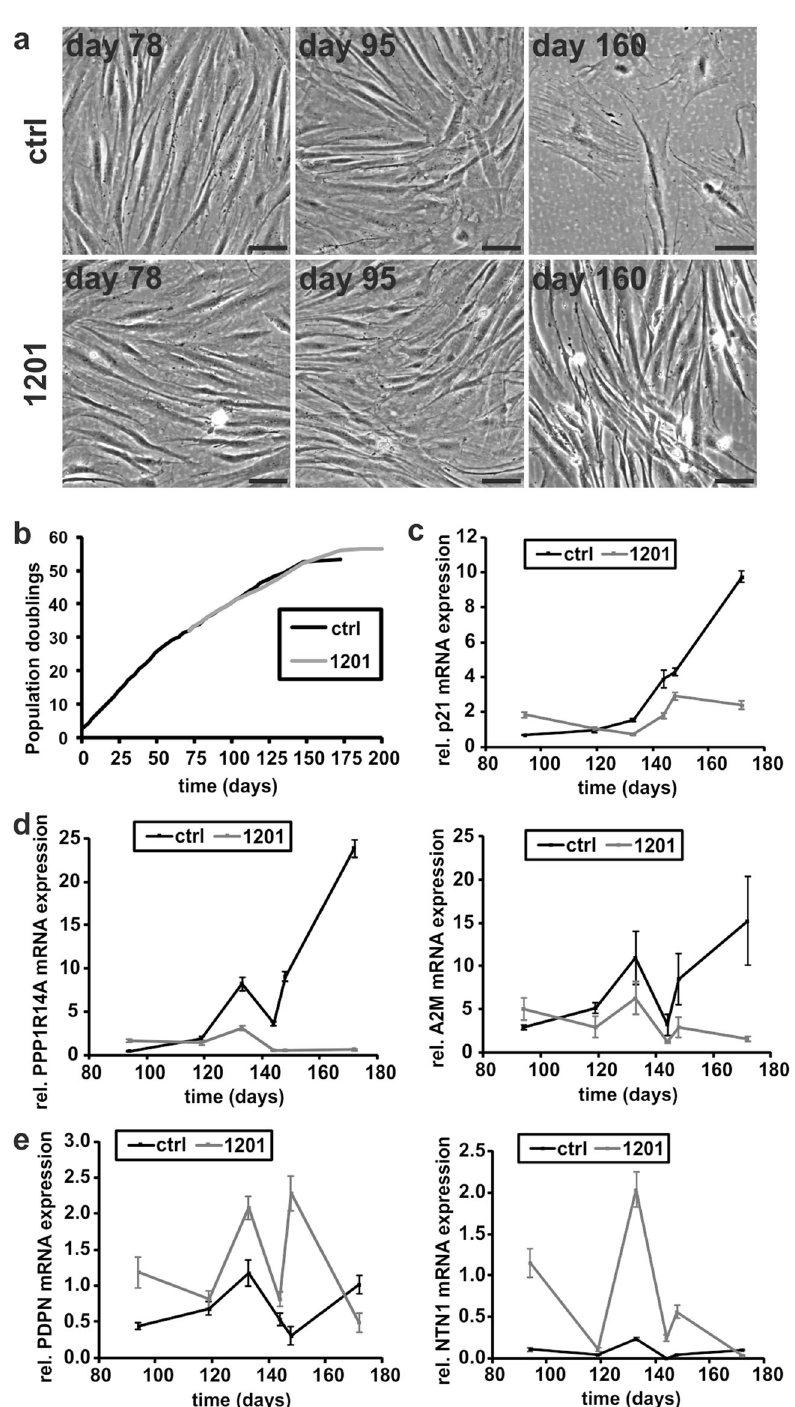
Fig. 1 1201 delays the acquisition of a senescent phenotype. a HDFs were cultivated with growth medium supplemented with 1201 from day 71 (PD 32) of the replicative lifespan experiment onwards. Control cells were cultivated with normal growth medium. Microscopic pictures were taken at ×100 magni fi cation. Scale bar, 100 µm. b Growth curve of the replicative lifespan experiment. At the end of the replicative lifespan the cell number was determined at regular intervals and population doublings were adjusted using the equation PD ¼ PD prev þ 3 : 32 (cid:2) ð logN (cid:3) logN Þ to compensate for decreasing cell density. At regular intervals during the lifespan experiment, RNA samples were prepared prev and the mRNA expression of c p21, d markers for the papillary and e reticular phenotype was determined with RT-qPCR. Expression levels of replicatively young (PD 11.5) control cells were set to 1. Data represent one experiment and error bars are calculated from four technical